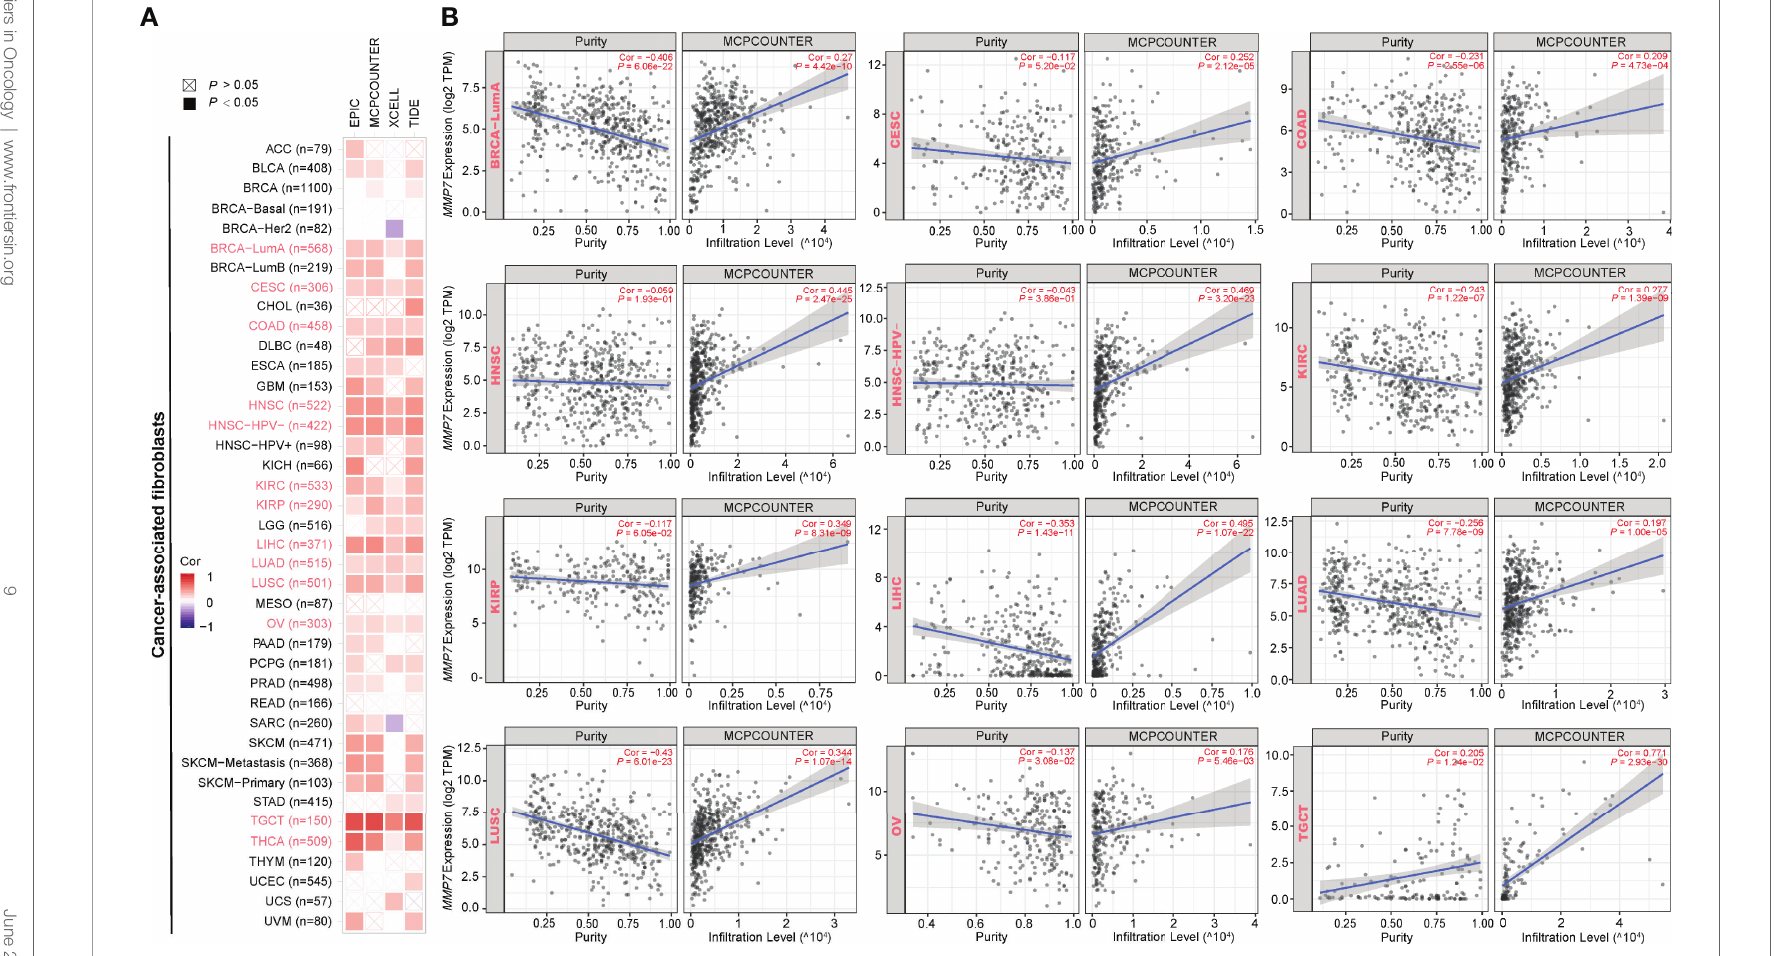
FIGURE 6 | Correlation between the expression of MMP7 and cancer-associated fi broblasts (CAFs) in fi ltration (TIMER2). (A) The heatmap of purity-adjusted Spearman ’ s correlation analysis between MMP7 gene expression and the in fi ltration levels of CAFs across TCGA cancers based on EPIC, MCPCOUNTER, XCELL, and TIDE algorithms. The red color indicates positive correlation while the purple color indicates negative correlation. (B) The scatter plots representing the relationship between CAFs in fi ltrates estimation value and MMP7 gene expression by the method of MCPCOUNTER are shown, in BRCA-LumA, CESC, COAD, HNSC, HNSC-HPV-, KIRC, KIRP, LIHC, LUAD, LUSC, OV, TGCT, and